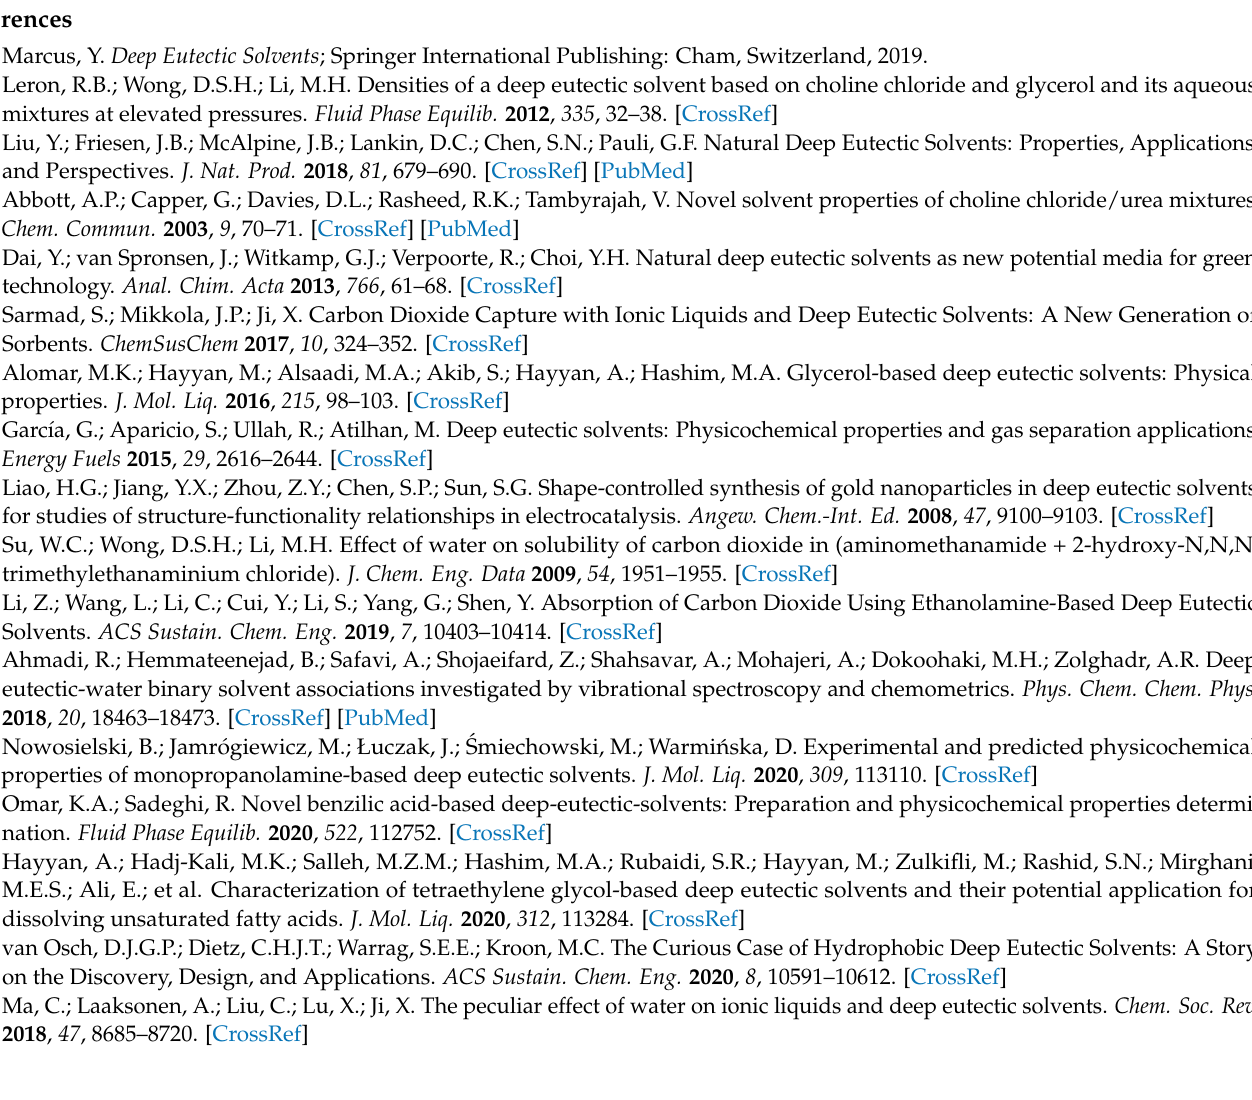
Table S11: Partial molar volumes of DESs and water in their binary mixtures at T = (293.15 to 313.15) K and at atmospheric pressure (0.1